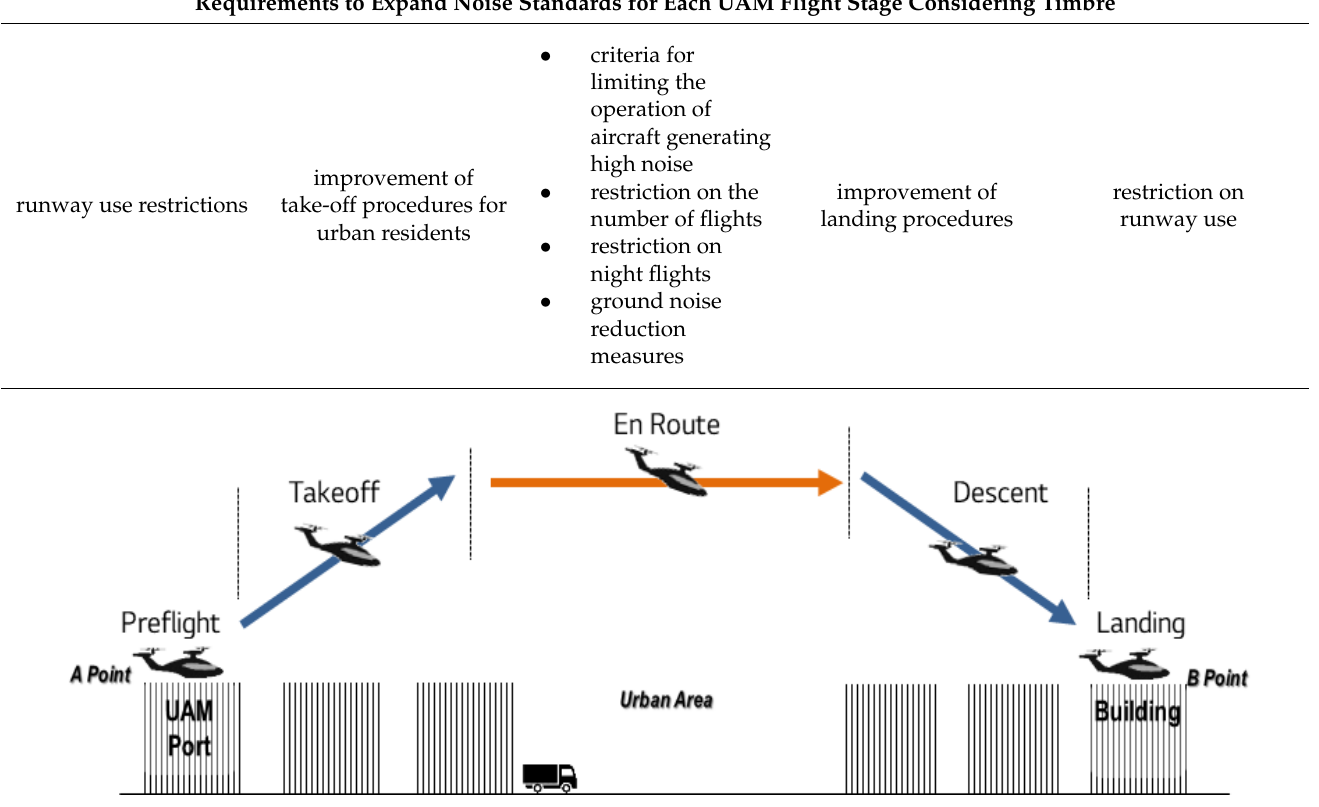
Table 8. Requirements to expand noise standards for each UAM flight stage considering